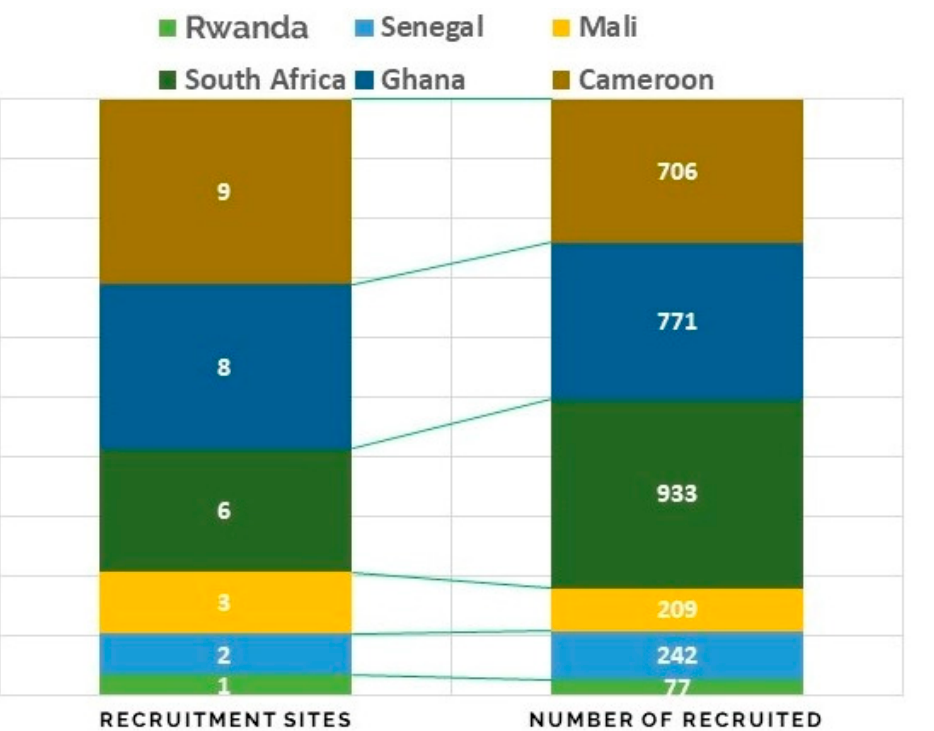
Figure 3. Distributions of the study participants that were recruited for the HiGeneS project in the six African countries between the years 2019–2020.